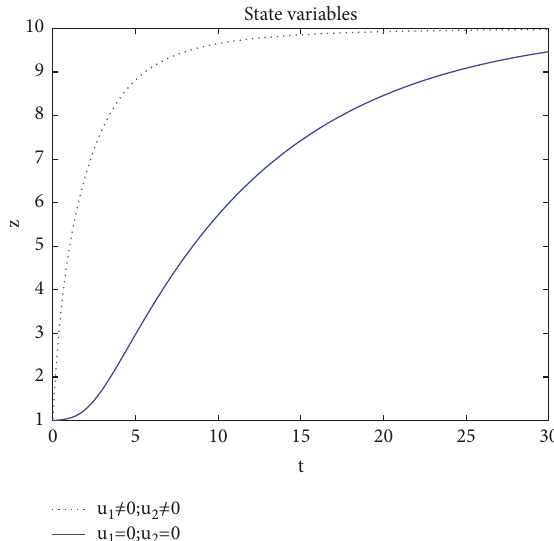
Figure 11: Evolution of number of 𝑧(𝑡) with or without control.